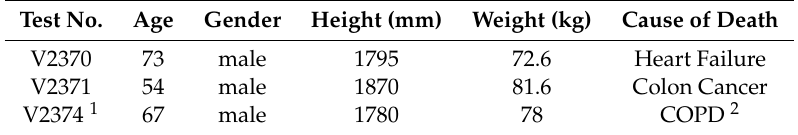
Table 1. Anthropometries and injuries of the tested